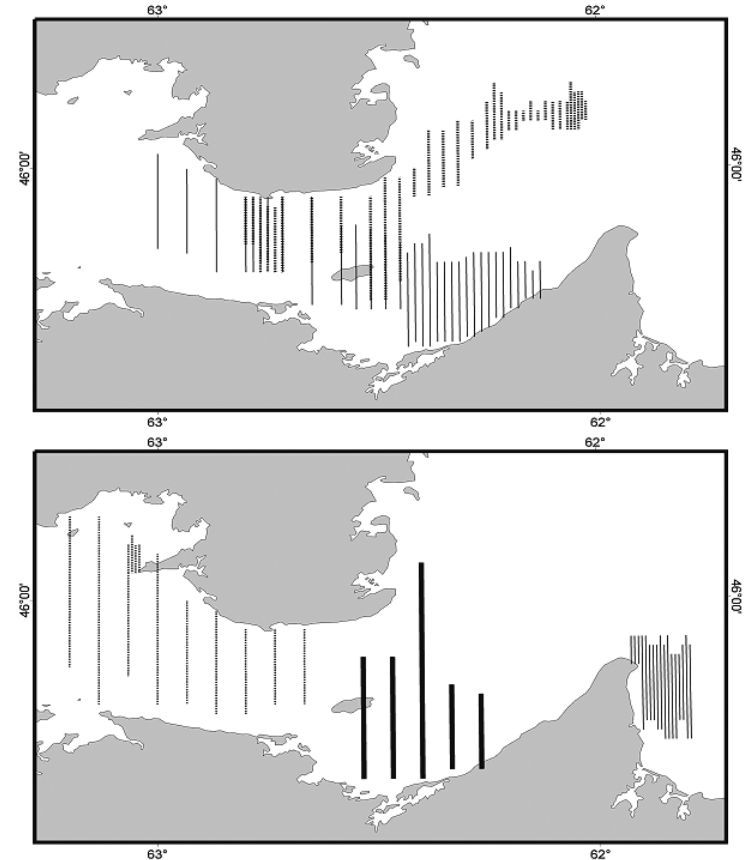
Fig. 4 . Transects of the 1997 visual survey flown on 22 and 26 January (respectively in bold and thin lines) (top). Transects of the 1997 visual survey flown on 28, 29 January and 4 February (respectively in bold, dotted and thin lines)